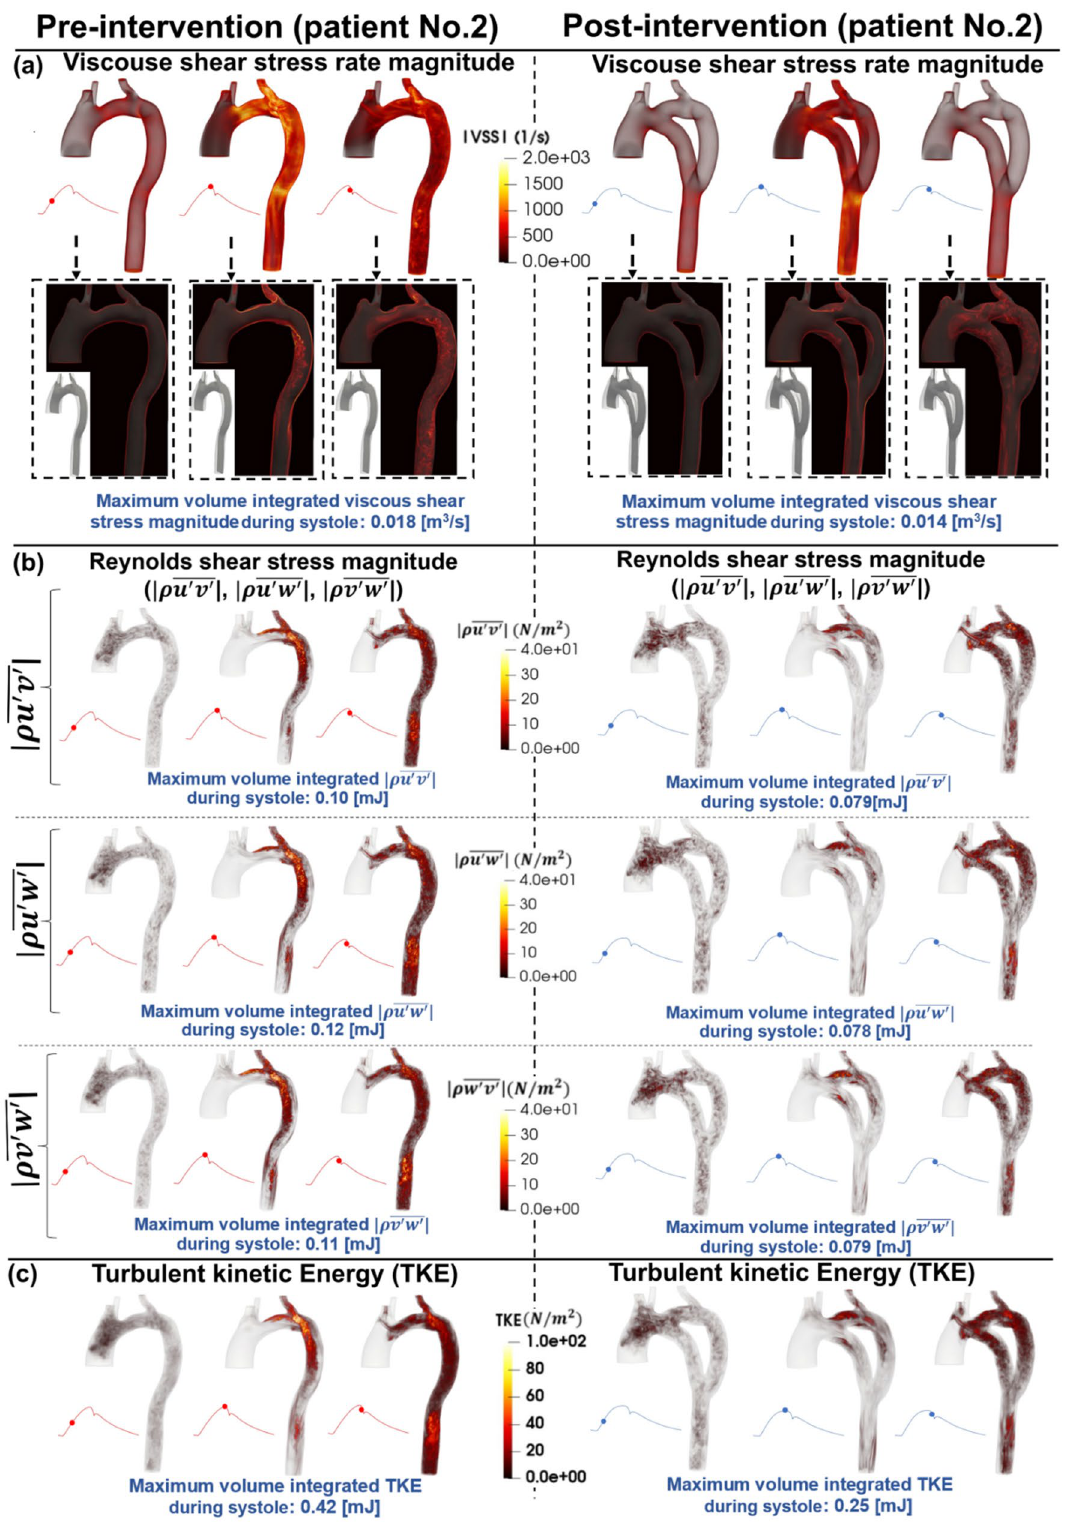
Figure 6. Flow modeling in Patient No. 2 in pre and post intervention status. ( a ) Viscous shear stress (VSS) magnitude; ( b ) Computed Reynolds Shear stress ( ρ u ′ v ′ , ρ u ′ w ′ and ρ w ′ v ′ ) magnitude; ( c ) Turbulent kinetic u ′ 2 + v ′ 2 + w ′ 2 energy (TKE), computed as 1 2 ρ , where u, v, w and ρ correspond to the three components of the instantaneous velocity vector and density. The bar and prime denote the ensemble averaged and fluctuating (cid:30) (cid:31) components,